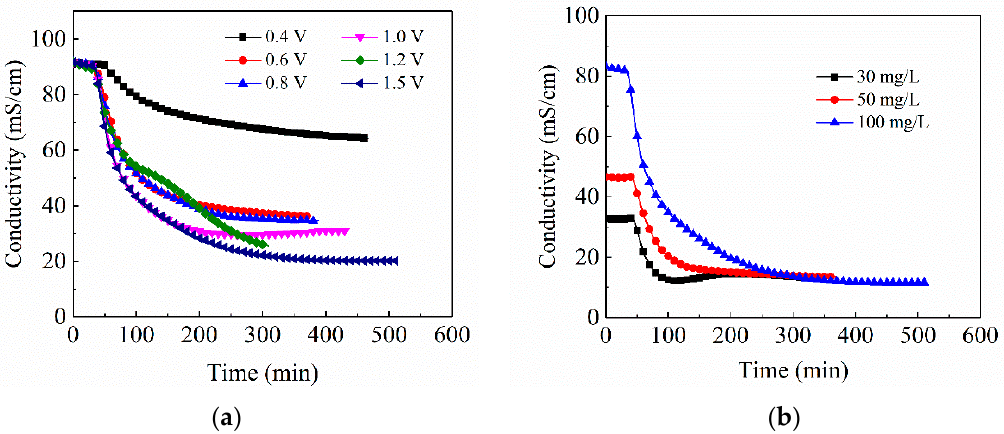
Figure 6. Adsorption curves of different CAs ( a ) for CuSO 4 solution and ( b ) the adsorption curves of carbon aerogel electrode for CuSO 4 solution at different voltages.